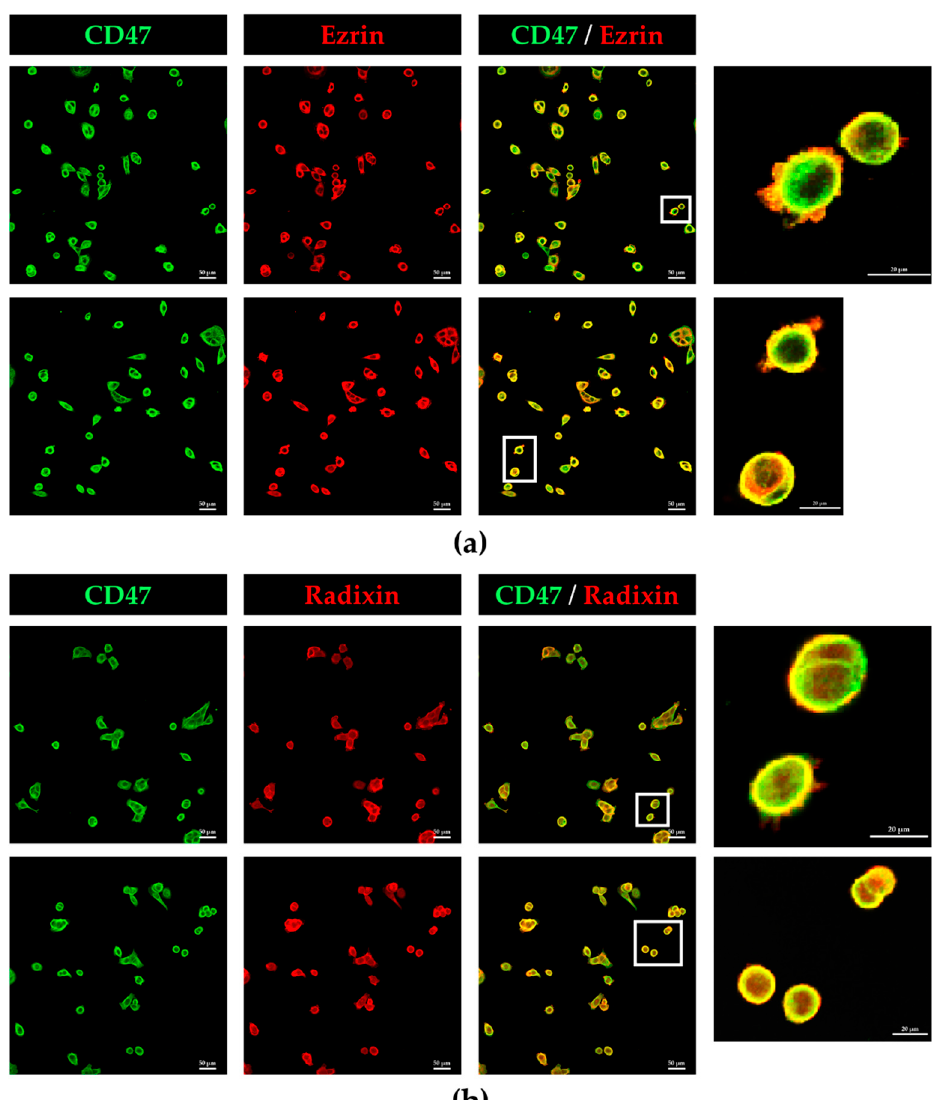
Figure 2. Colocalization of CD47 with ezrin and radixin in KP-2 cells. Subcellular distribution of CD47 labeled with Alexa Fluor 488 (green) and ( a ) ezrin and ( b ) radixin labeled with Alexa Fluor 594 (red) in the confocal laser scanning microscopy (CLSM) analysis. Scale bars: 50 µm. Higher magnification images in the rightmost are from the corresponding white rectangle region in the merged panels. Scale bars: 20 µm.